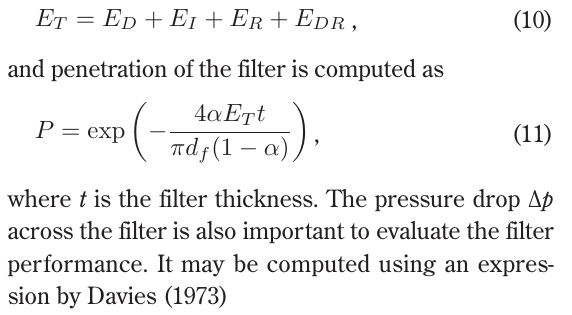
Fig. 1 Set-up for test using silver